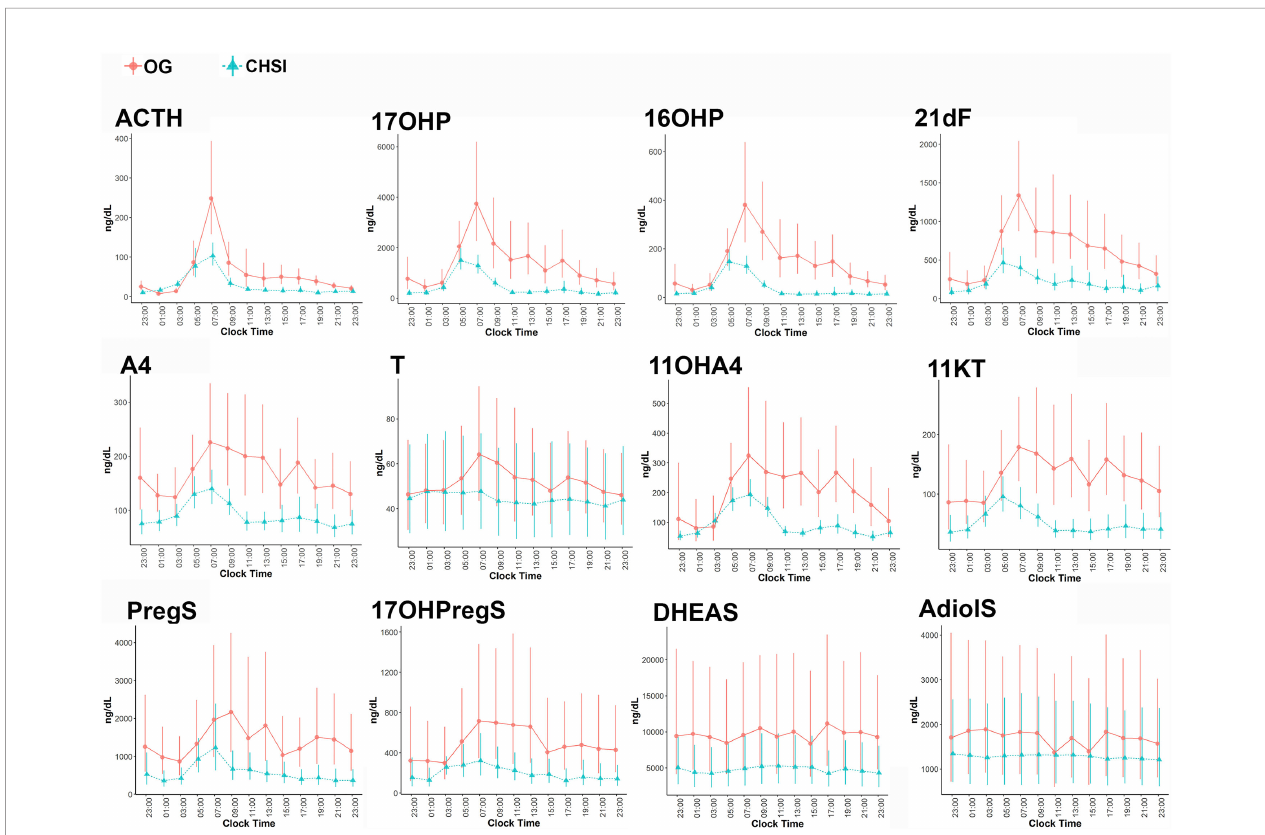
FIGURE 1 | Serum concentrations of ACTH and steroids during conventional oral glucocorticoid therapy (OG, circles), and into 6 months of continuous subcutaneous hydrocortisone infusion (CSHI, triangles). Central data represent the geometrical means of all participants, and the vertical lines represent the standard errors of the geometrical means. 21dF, 21-deoxycortisol; 17OHProg, 17 a -hydroxyprogesterone; 16OHProg, 16 a -hydroxyprogesterone; A4, androstenedione; 11OHA4, 11 b -hydroxyandrostenedione; 11KT, 11-ketotestosterone; T, testosterone PregS, pregnenolone sulfate; 17OHPregS, 17 a -hydroxypregnenolone sulfate; DHEAS, dehydroepiandrosterone sulfate; AdiolS,